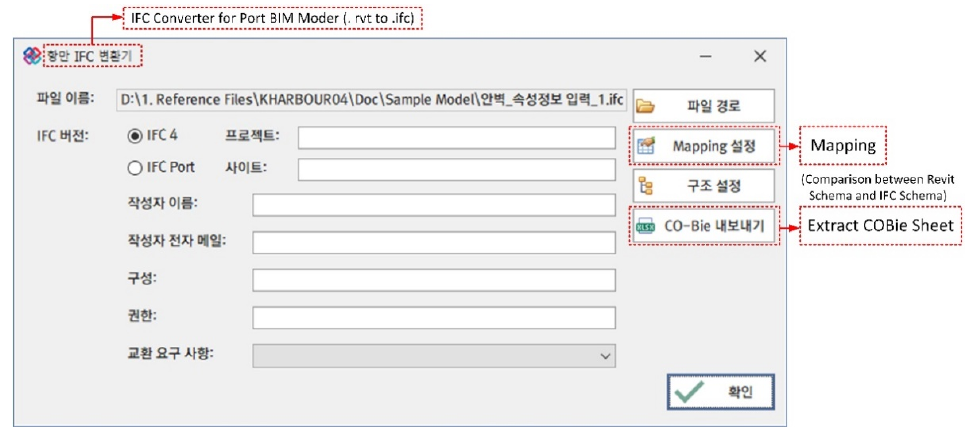
Figure 19. The last step of port COBie System, the output of port COBie spreadsheet.